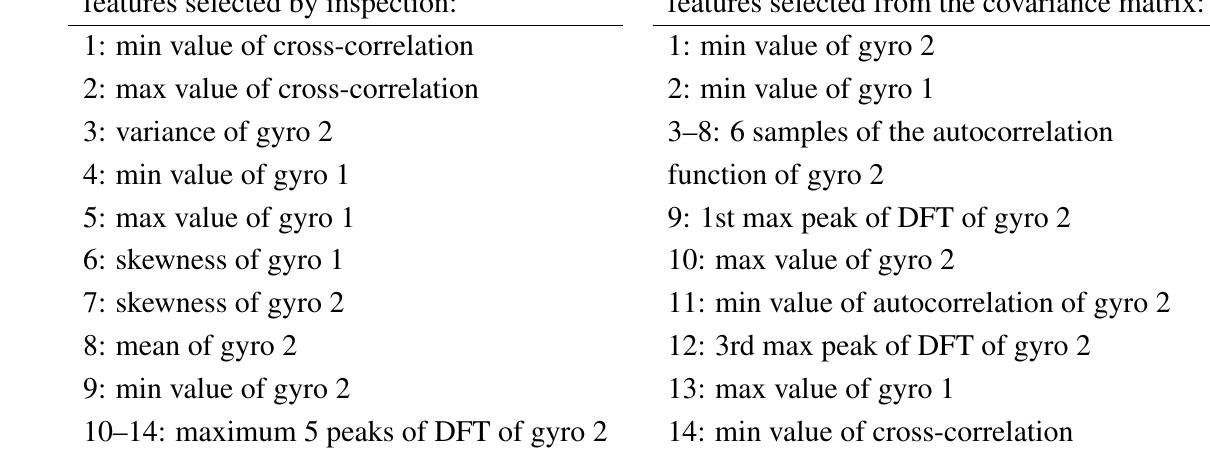
Table 1. Features selected by inspection (left) and the features selected by using the covari- ance matrix